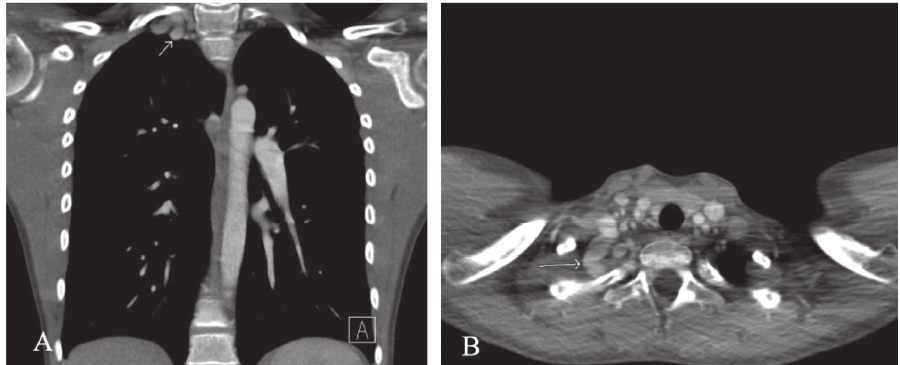
Figure 2: Computed tomography of chest with contrast; coronal (a) view and transverse (b) thin-slice view of the aberrant blood vessel arising from the right brachiocephalic artery, between the right vertebral and right subclavian